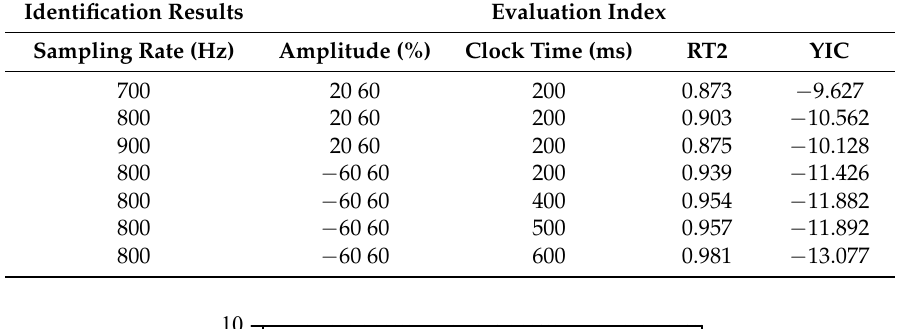
Table 4. RT2 and YIC under different identification conditions.